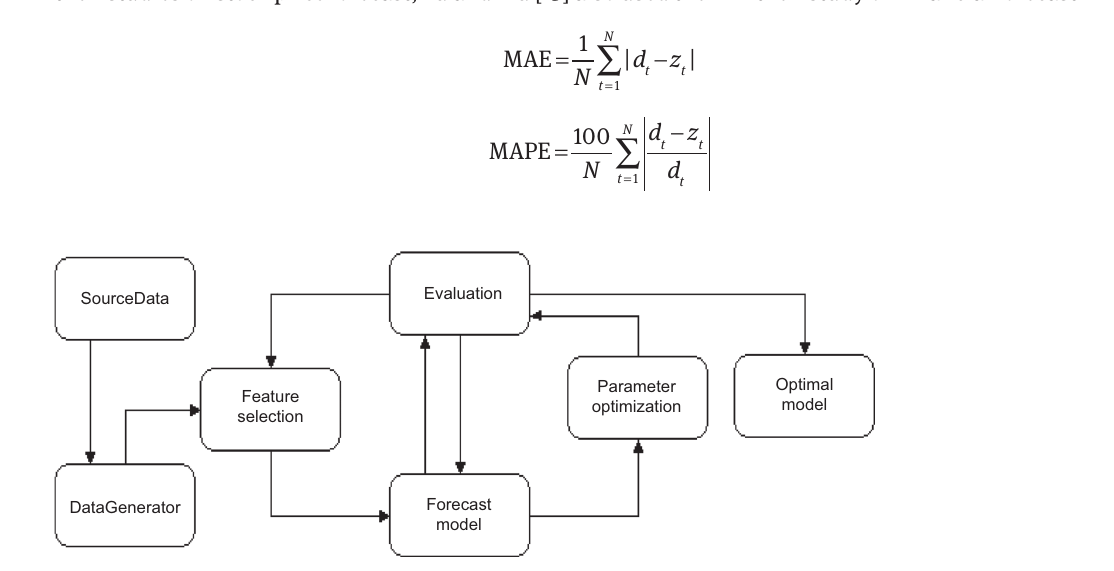
Figure 2. The Wrapped Hybrid Forecast